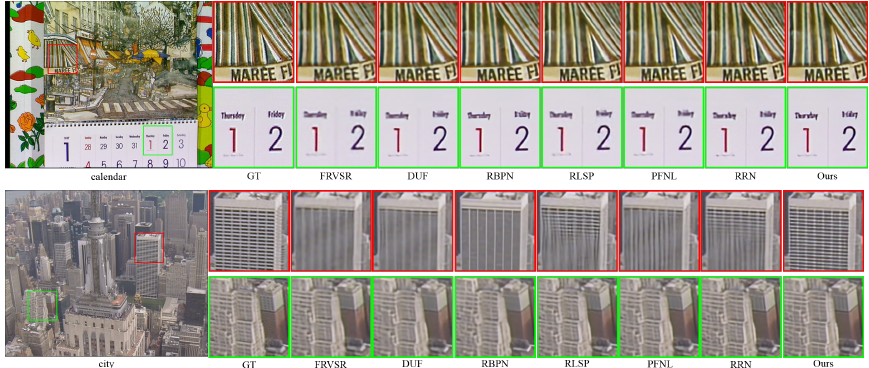
Figure 8. Comparison of reconstruction results with different methods in the Vid4 dataset.